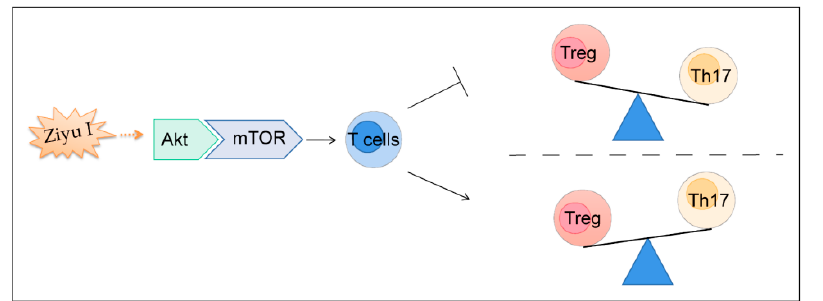
Figure 7. Graphical abstract. The therapeutic effect of Ziyu I on CIA is exerted by inhibiting the activity of Akt - mTOR signaling, reducing the differentiation of Th17, and thereby restoring the balance of Th17/Treg. Ziyu I: Ziyuglycoside I, Akt: protein kinase B 1, mTOR: mechanistic target of rapamycin, Treg: regulatory T cell, Th17: helper T cell 17.